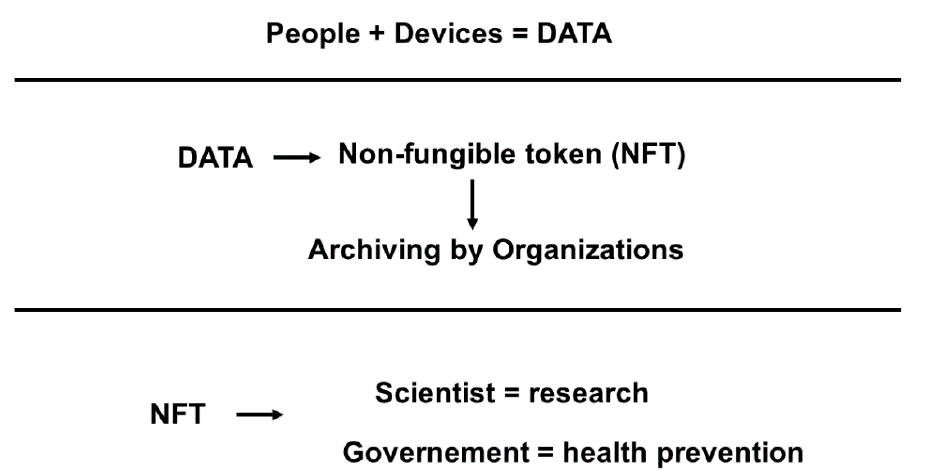
Figure 3. Graphic representation of the passage of the data from people to the researchers and public organizations.